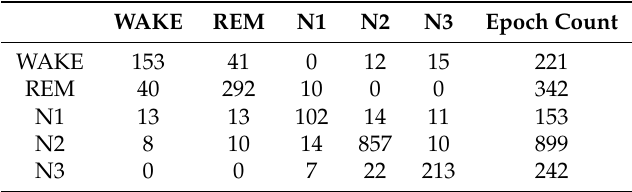
Table 4. Confusion